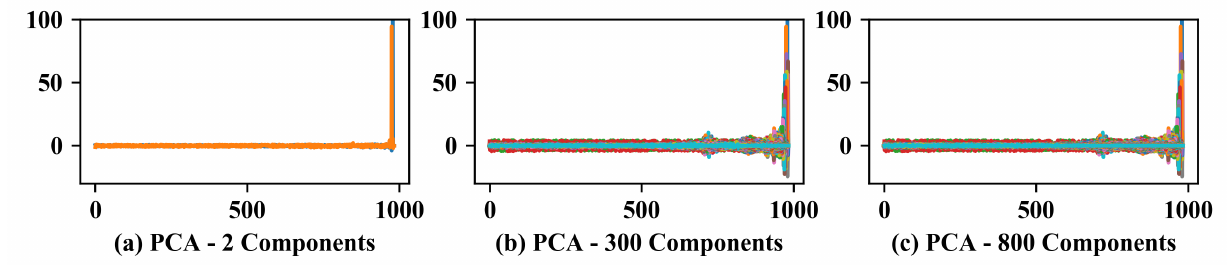
Figure 11. Reduced dimensionality of raw signal using PCA with a different quantity of principal